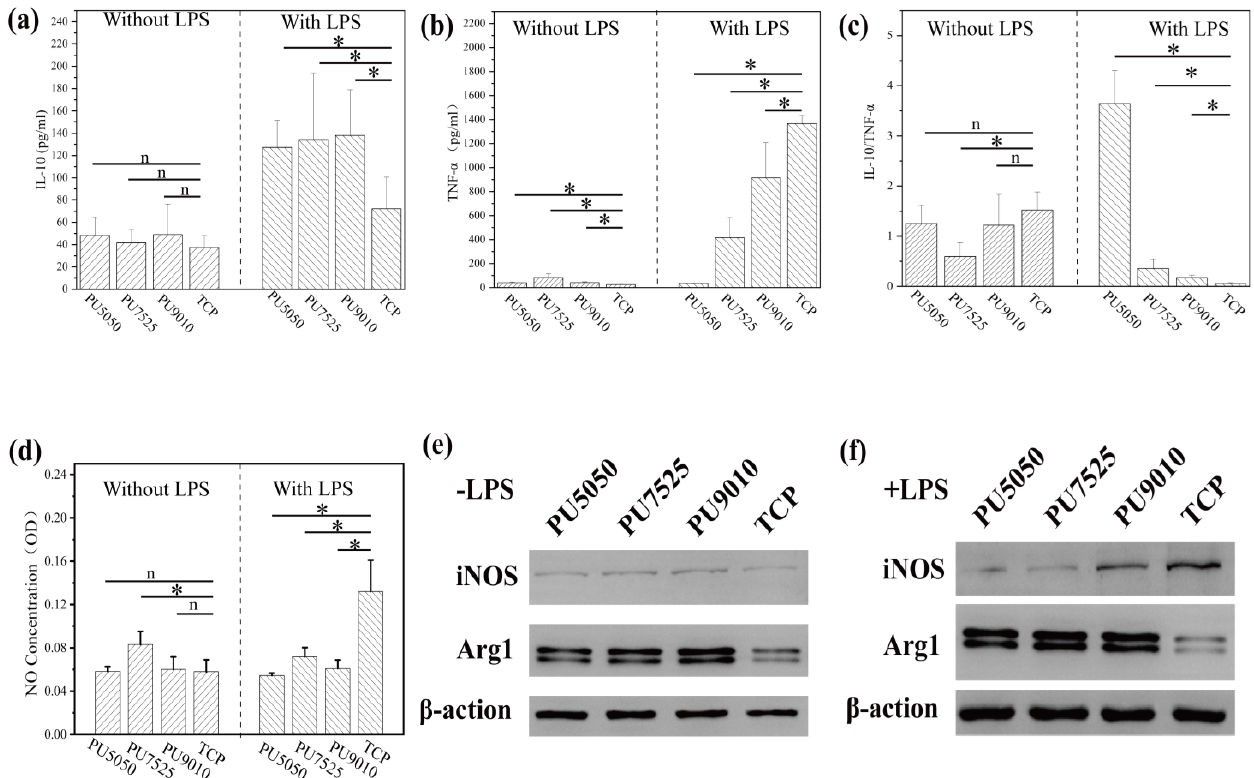
Figure 3. ( a ) The secretion of TNF-α from BV2 cells on PU5050, PU7525 and PU9010 scaffolds and TCP, with and without LPS. ( b ) The secretion of IL-10 from BV2 cells on PU5050, PU7525 and PU9010 scaffolds and TCP, with and without LPS. ( c ) IL- 10/TNF-α with and without LPS. ( d ) NO secretion from BV2 cells on PU5050, PU7525 and PU9010 scaffolds and the TCP group, with and without LPS. ( e ) Three marker proteins (iNOS, Arg1 and β-action) in BV2 cells, detected using WB analysis, without LPS. ( f ) Three marker proteins (iNOS, Arg1 and β-action) in BV2 cells, detected using WB analysis, with LPS. Data are expressed as mean ± SD (n ≥ 3). * p < 0.05 compared with TCP. n p > 0.05 compared with TCP.